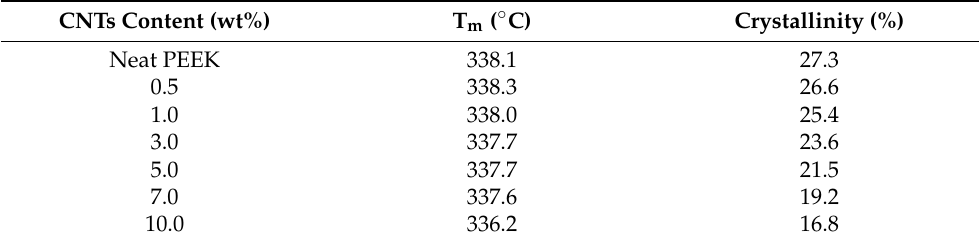
Figure 6. DSC heating curve at various CNTs content for PEEK/CNTs composites: ( a ) before annealing treatment, ( b ) after annealing treatment. Table 4. Crystallization parameter of the PEEK/CNTs composites before annealing.